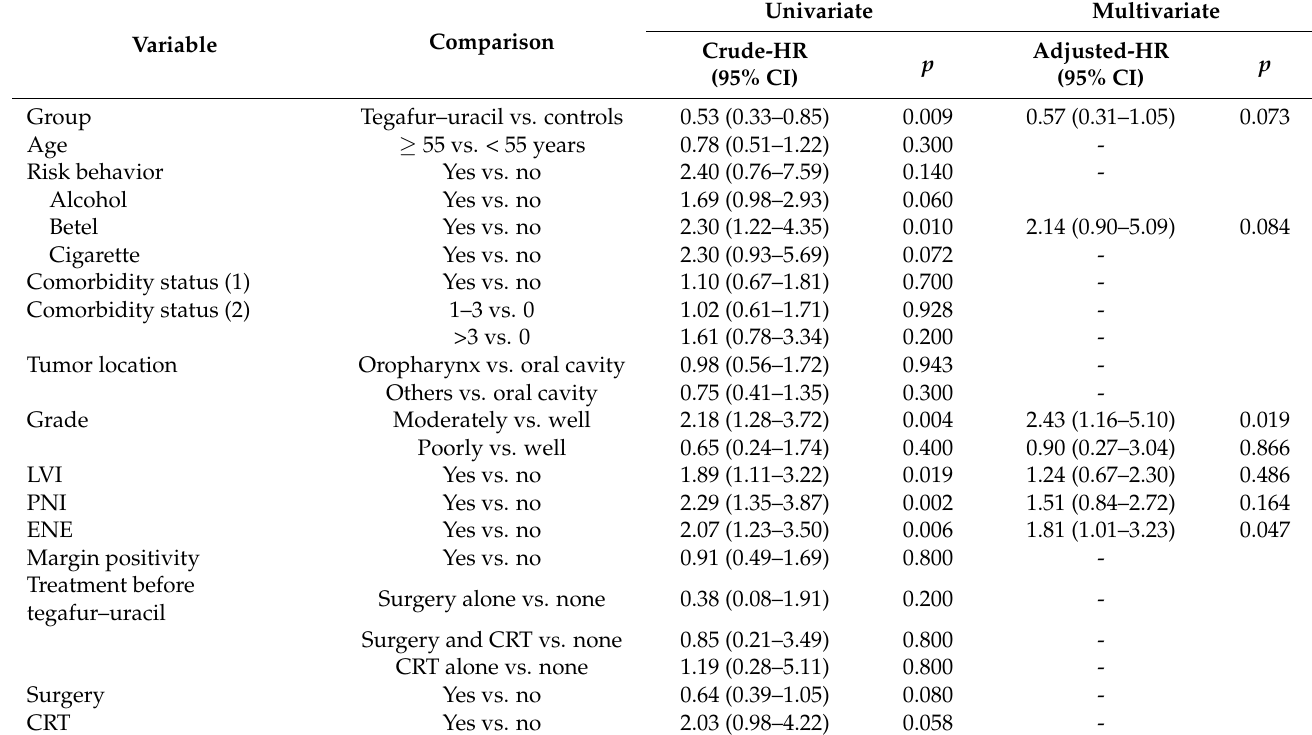
Table 5. Cox regression analysis for overall